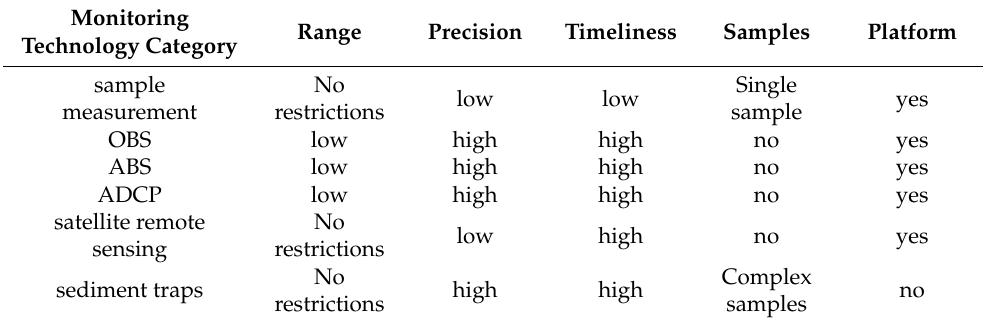
Table 1. Comparison of mainstream monitoring technologies for sediment transport